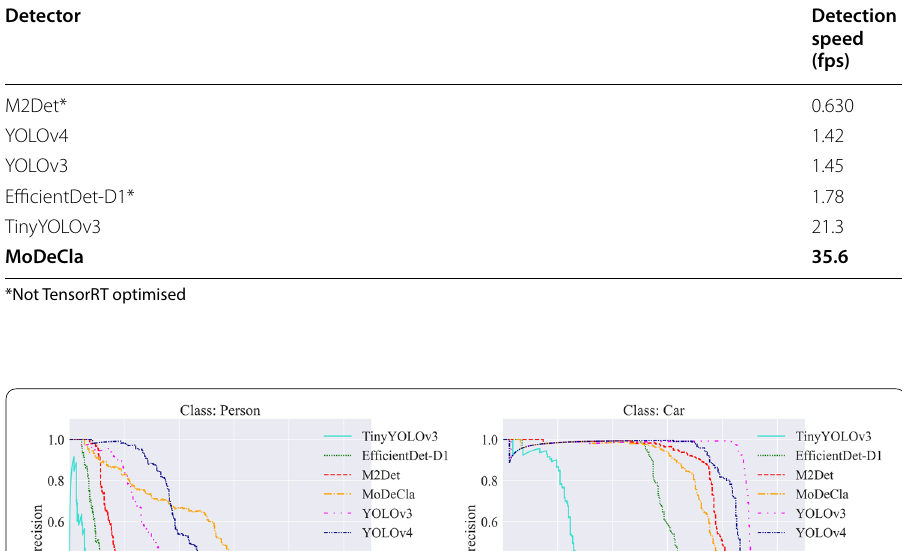
Table 4 Detection speeds of the algorithms benchmarked on a Jetson Nano